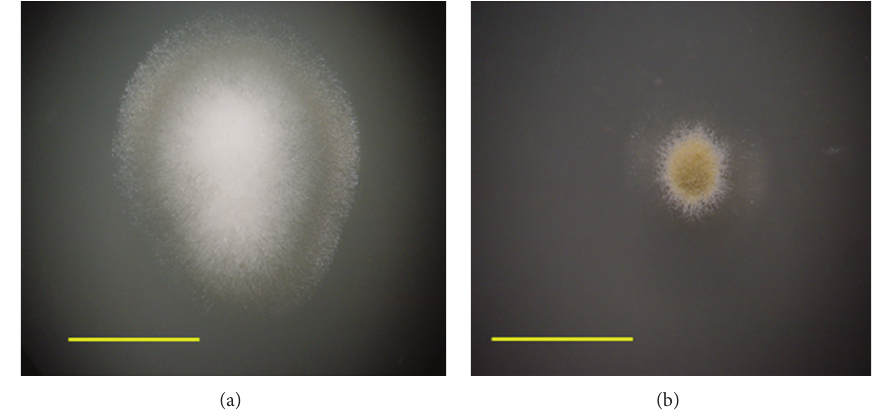
Figure 3: Characterization of mutant Aspergillus oryzae colony size and onset of spore production. The antibacterial A. oryzae isolate (b) exhibited altered morphology consisting of smaller colony size, reduced mycelia formation, and earlier and heavier visible spore production compared to parental A. oryzae (a). Colonies are shown at two days after inoculation on SAB plates. Without magnification, spores are visible as dark coloration (b), while mycelia are bright white (a). Scale bars = 0.75